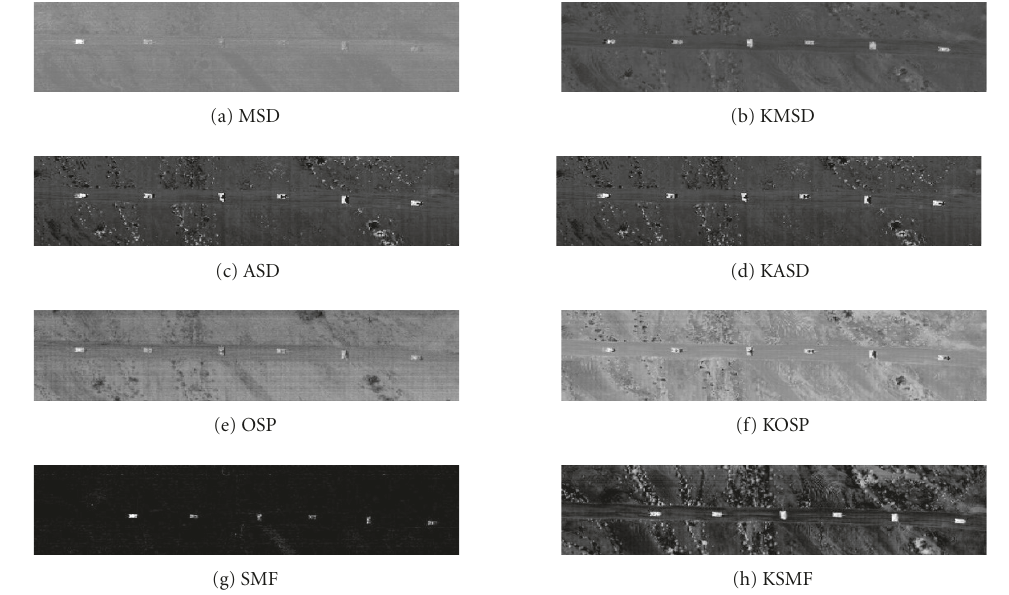
Figure 4: Detection results for the DR-II image using the conventional detectors and the corresponding kernel versions.